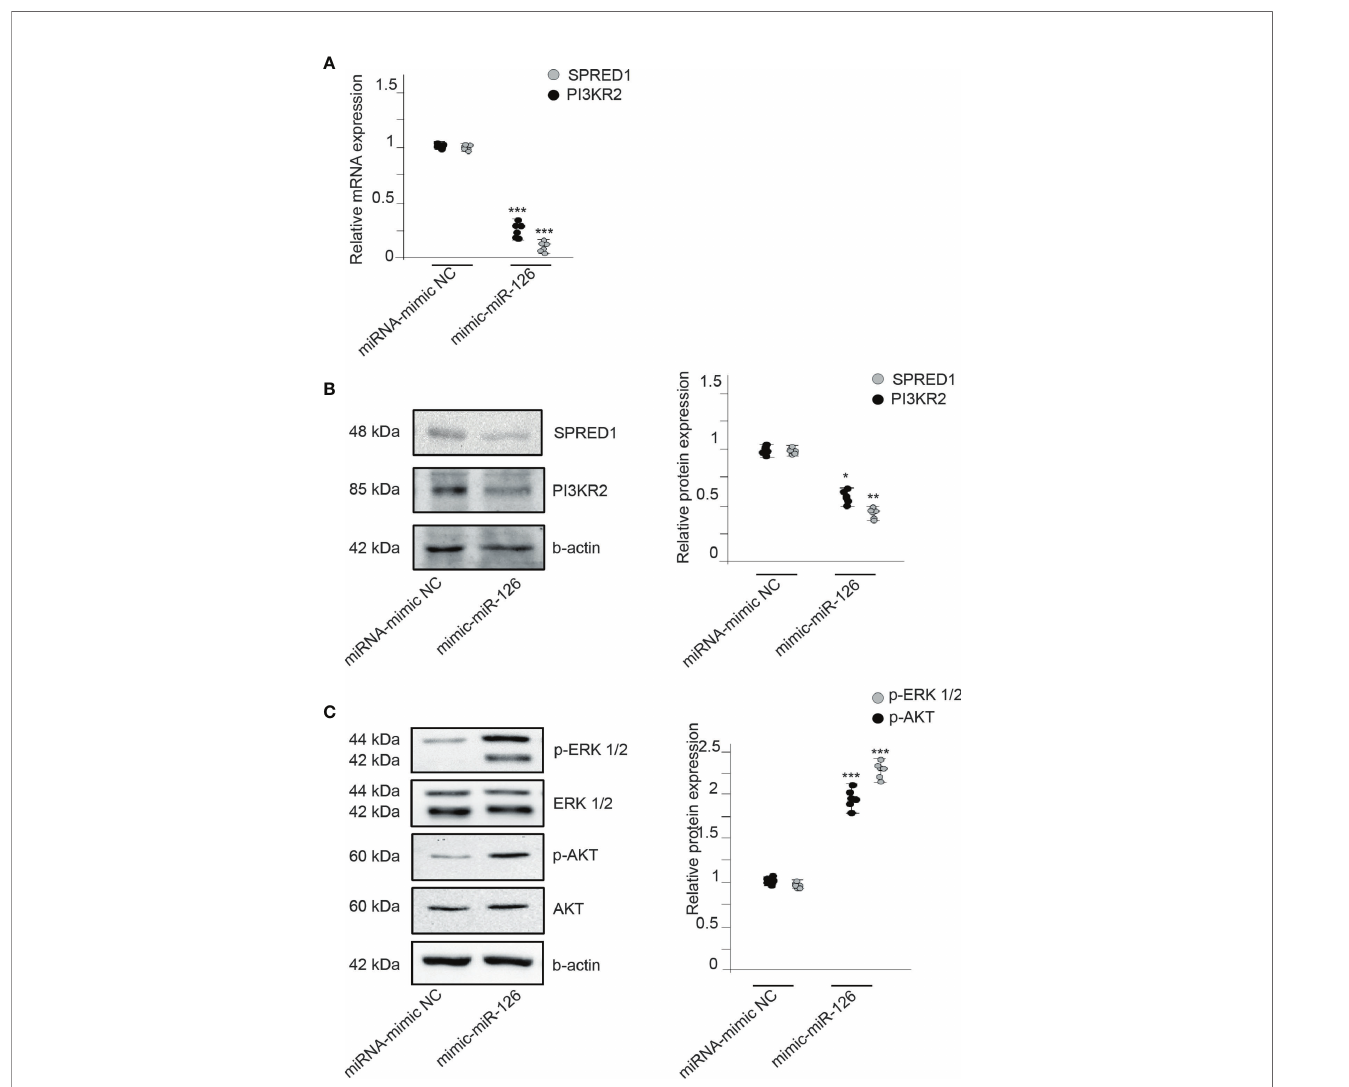
FIGURE 5 | MiR-126 regulates VEGF signaling by repressing SPRED1 and PI3KR2. (A) Relative expression of SPRED1 and PI3KR2 mRNA levels in RMCs transfected with miRNA-mimic NC or mimic-miR-126. Values are expressed as mean ± SEM. Statistical analysis was performed by ANOVA followed by Tukey ’ s post-hoc test. *** p < 0.001 vs. miRNA-mimic NC ( N = 6). (B) SPRED1 and PI3KR2 protein levels in RMCs transfected with miRNA-mimic NC or mimic-miR-126. Blots are representatives from 6 independent experiments. Values of relative protein levels normalized to b -actin are expressed as mean ± SEM. Statistical analysis was performed by ANOVA followed by Tukey ’ s post-hoc test. * p < 0.05 and ** p < 0.01 vs. respective miRNA-mimic NC. (C) Western blot analysis of phospho-ERK 1/2, ERK 1/2, phospho-AKT Ser473, and AKT protein in RMCs transfected with miRNA-mimic NC or mimic-miR-126. To test for equal loading, Western blots were reprobed by b -actin ( N = 6). Quantitative analysis of phospho-ERK 1/2 relative to ERK 1/2 and phospho-AKT Ser473 relative to AKT in each condition. Values are expressed as mean ± SEM. Statistical analysis was performed by ANOVA followed by Tukey ’ s post-hoc test. *** p < 0.001 vs. respective miRNA-mimic NC ( N =